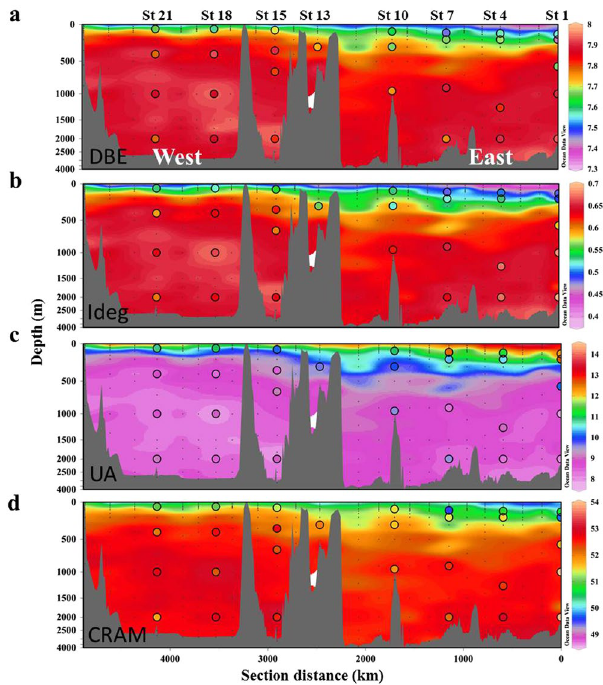
Figure 4. Distributions of the estimated molecular parameters. ( a ) double bond equivalent (DBE) in number, ( b ) degradation index (Ideg) unitless, ( c ) unsaturated aliphatic compounds (UA) in % and ( d ) carboxyl- rich alicyclic molecules (CRAM) in % for the whole Mediterranean Sea determined from fluorescence measurements. Colored dots represent molecular parameters calculated by FT-ICR-MS analysis. Figure created using Ocean Data View (version 4.7.8, R. Schlitzer, 2016. http://odv.awi.de).